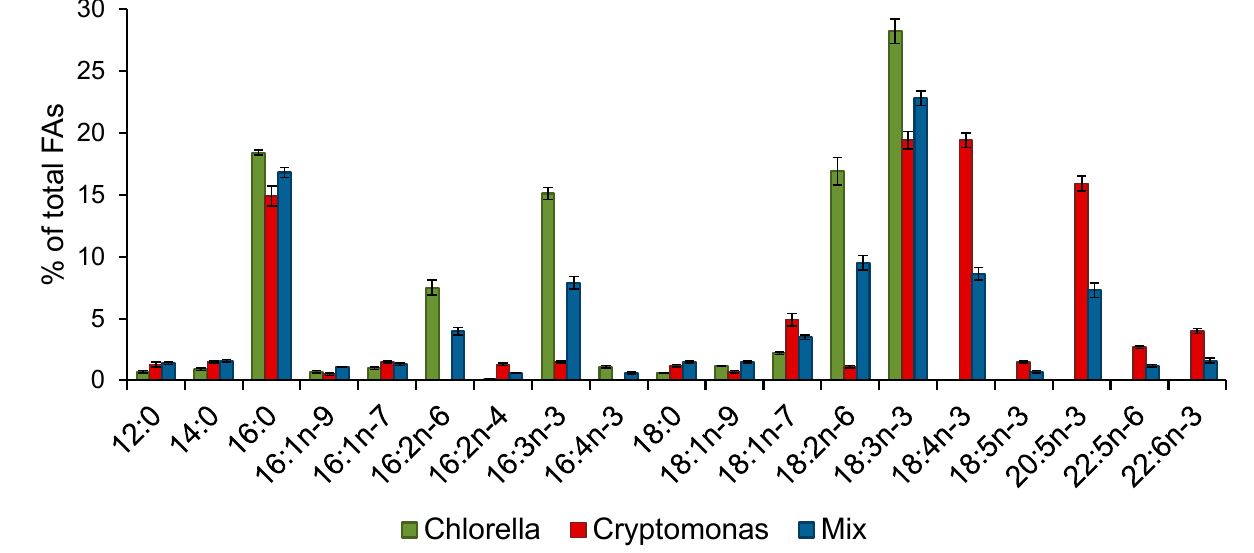
Figure 2. Mean values ( ± standard errors (SE)) of percentages of quantitatively prominent fatty acids (FAs) (% of total FAs) in biomass of Chlorella vulgaris (numbers of samples, n = 9), Cryptomonas sp. ( n = 9) and their mixture ( n = 11).